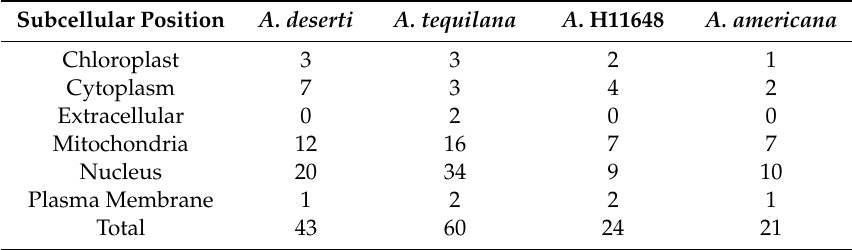
Table 1. Numbers of Agave Small Auxin Up-regulated RNA ( SAUR ) genes located at di ff erent subcellular